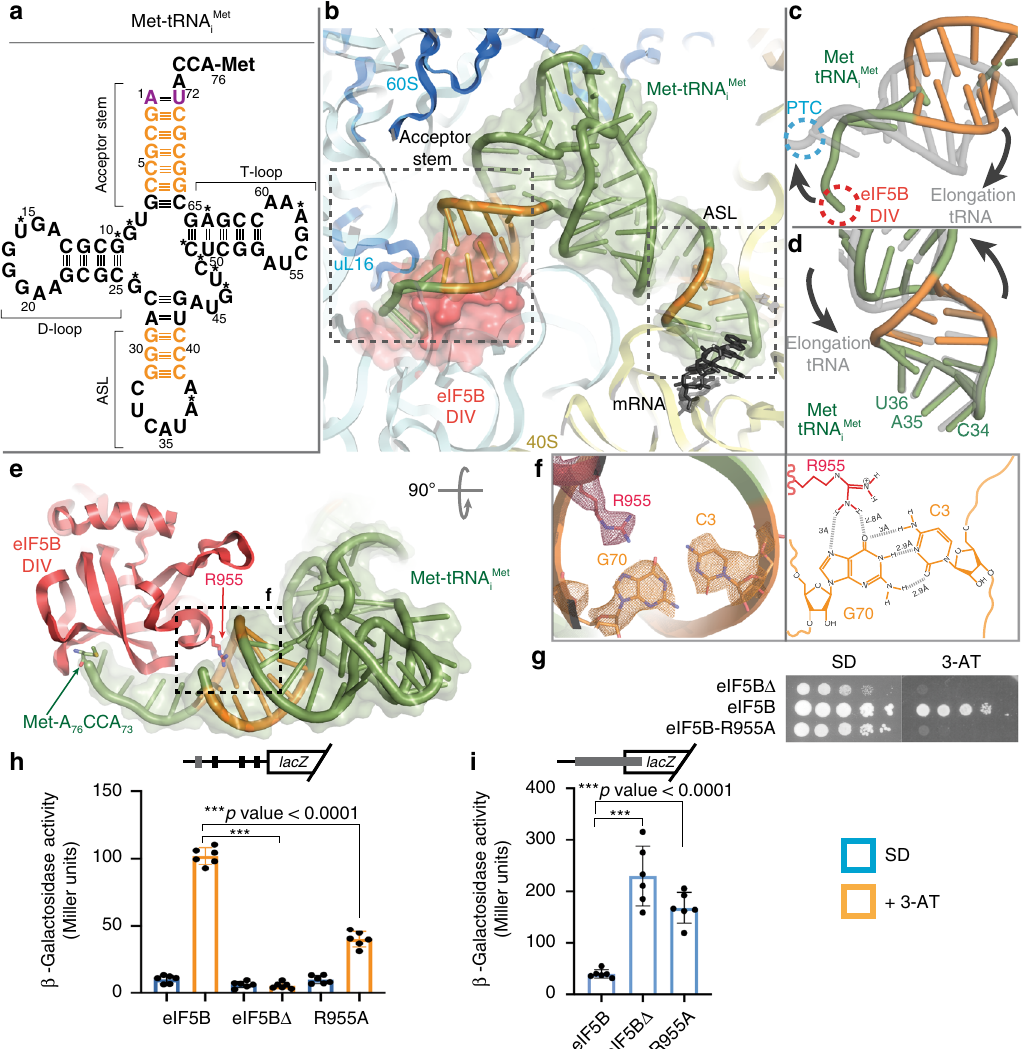
Fig. 2 Role of the G – C base-pairs clusters in Met-tRNA i Met conformation. a Sequence diagram of the S. cerevisiae Met-tRNA i Met with initiator-speci fi c base pairs colored in orange and modi fi ed nucleotides marked with asterisks. b Overview of the conformation adopted by Met-tRNA i Met on the 80S-IC complex with the initiator-speci fi c G – C base pairs colored in orange. c Superposition of Met-tRNA i Met (green) with a P site classical-state elongation tRNA (gray) reveals a distorted con fi guration of the acceptor stem of Met-tRNA i Met when compared with an elongation peptidyl-tRNA. This distortion prevents the 74 CCA 76 -Met end of Met-tRNA i Met from reaching the peptidyl transferase center (PTC, blue) on the 60S. d In contrast, the ASL of Met-tRNA i Met has reached its fi nal position when compared with an elongation tRNA in the P site. e The arginine residue 955 at DIV of eIF5B speci fi cally recognizes the Hoogsteen edge of the base of nucleotide G70 of Met-tRNA i Met (red arrow, R955). f Cryo-EM density for side chains and individual bases in the area around eIF5B R955. On the right, chemical diagram with contacts and distances indicated. g – i Yeast growth and GCN4-lacZ reporter assays of strains lacking eIF5B or expressing wild-type or R955A mutant. Cells were spotted on minimal (SD) or starvation (3-AT) medium ( g ) or assayed for ß- galactosidase activity following introduction of a wild-type GCN4-laZ reporter ( h ) or a derivative in which an extended version of uORF1 overlaps, out-of- frame, the GCN4 start codon ( i ). Results are the average and standard deviation of six independent transformants combined from two independent experiments with three replicates each; p values were calculated using two-sided Student ’ s t test. The p values for panel ( h ) are eIF5B vs. eIF5B Δ : 7.57349× 10 − 12 , eIF5B vs. eIF5B-R955A: 6.30158 × 10 − 9 and for panel ( i ) are eIF5B vs. eIF5B Δ : 1.23215 × 10 − 5 , eIF5B vs. eIF5B-R955A: 1.3313 × 10 − 6